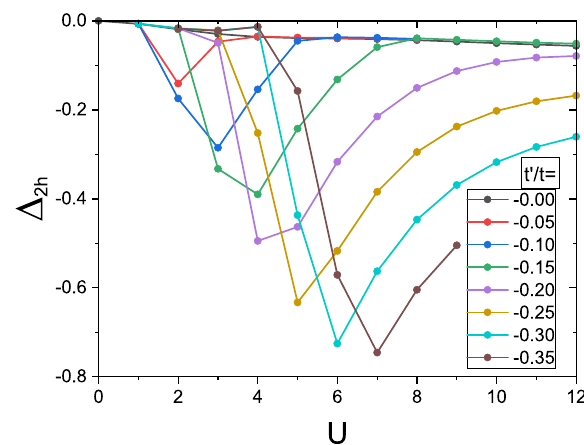
Fig. 2 Hole pairing energy. Pairing energy Δ 2h of two holes in a 4 × 4 cluster with periodic boundary condition as a function of U and t 0